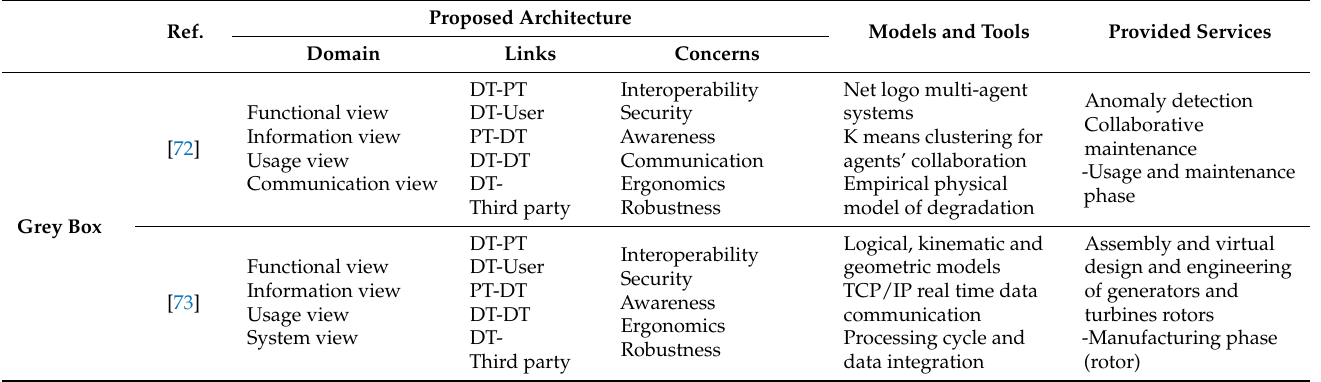
Table 9. Hybrid twins for power plants monitoring and DT-OMASE for smart